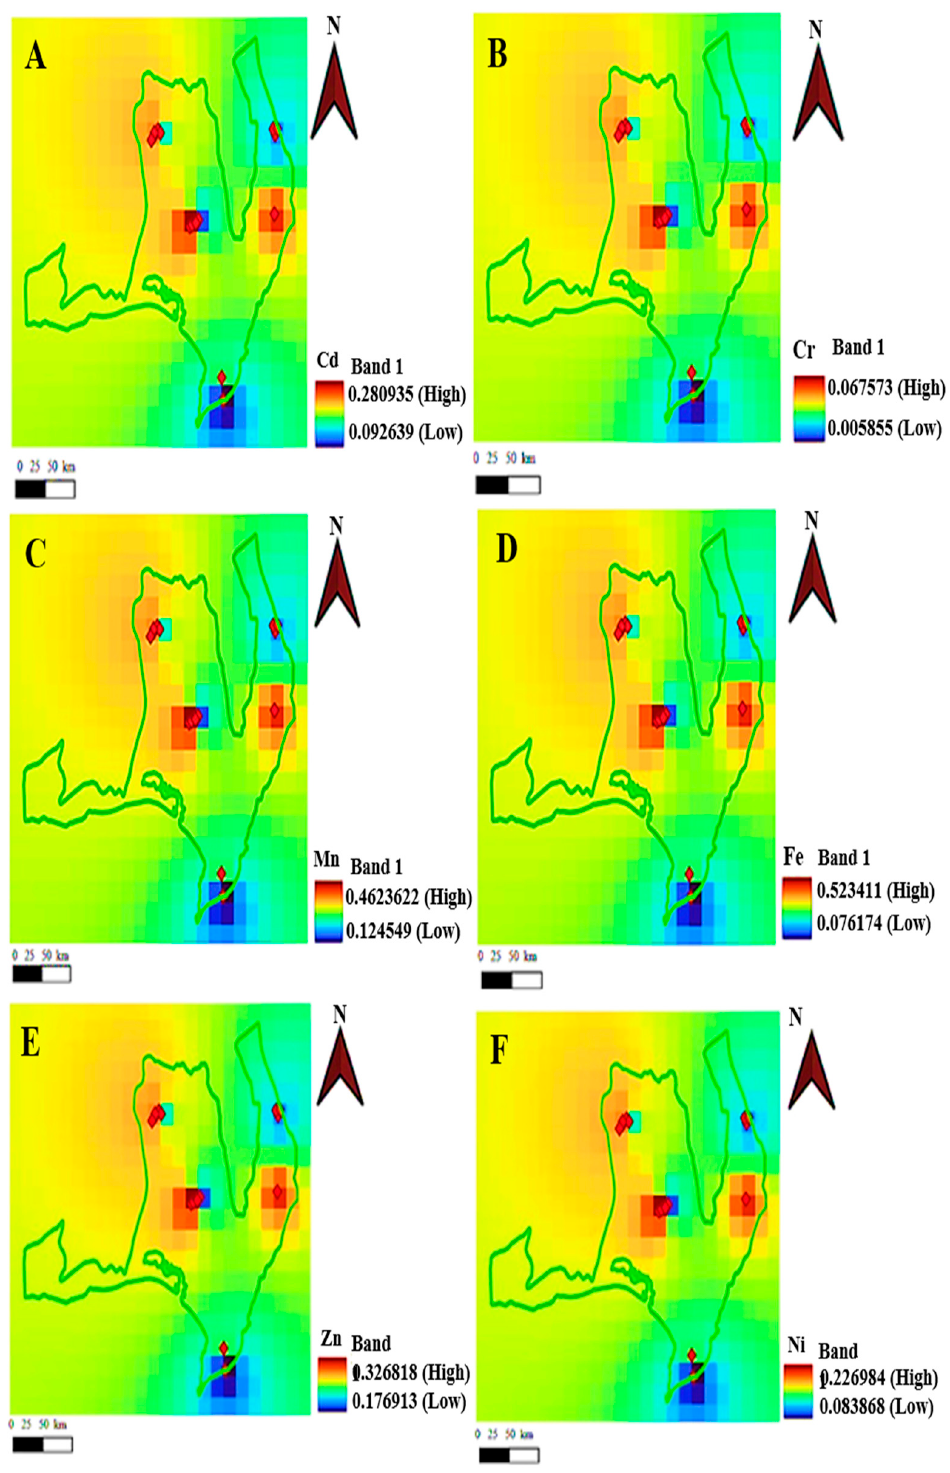
Figure 4. ( A – F ) indicate spatial distribution of heavy metals ( A ) Cd, ( B ) Cr, ( C ) Mn, ( D ) Fe, ( E ) Zn, and ( F ) Ni in the study area of Lasbela, coastal area of Baluchistan,